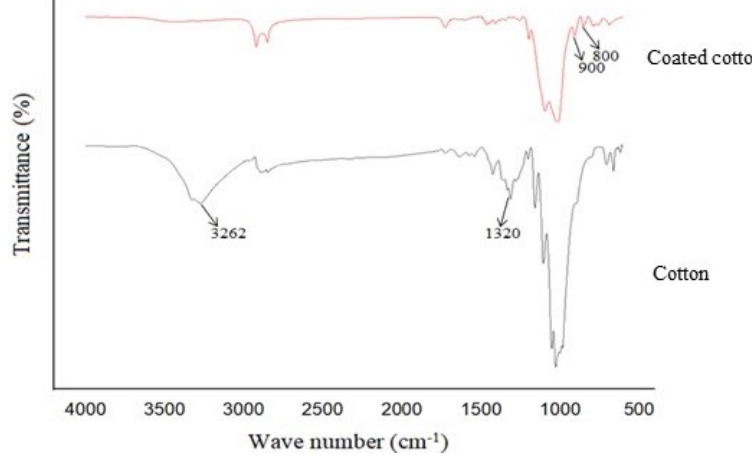
Figure 5. FTIR of treated cotton fabric with modified nano titania.